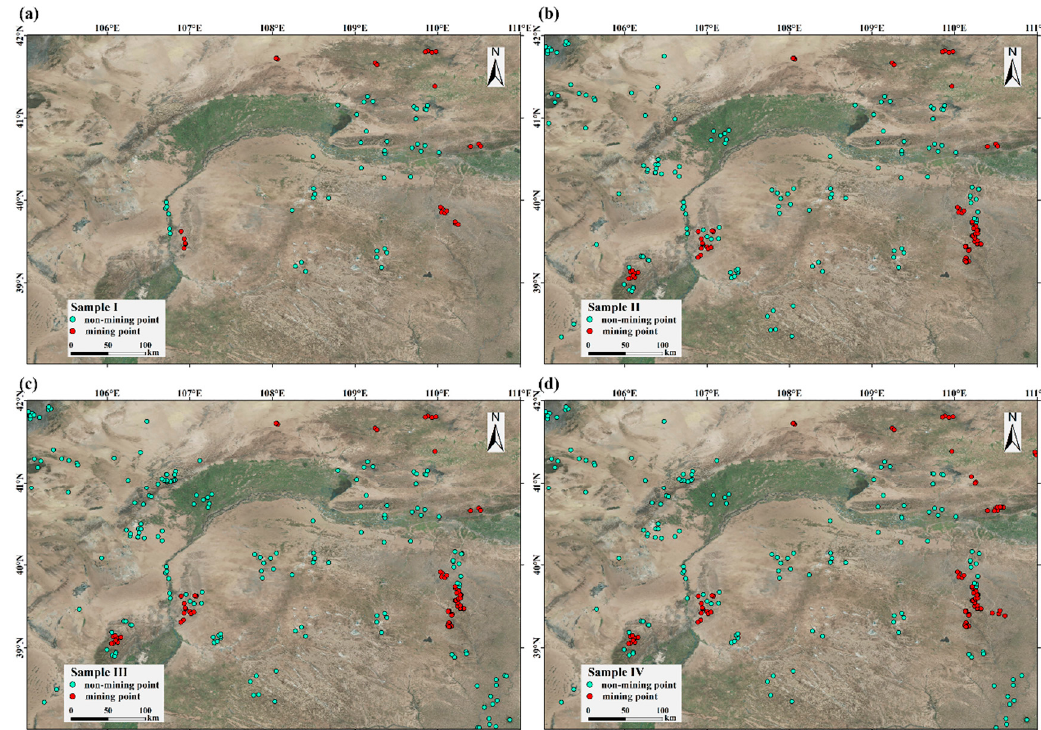
Figure 7. Distribution and number of sample points. ( a ) Sample I has only 72 sample points (mine points:non-mine points = 26:46), ( b ) Sample II has 213 sample points (mine points:non-mine points = 71:142, ( c ) Sample III has 253 sample points (mine points:non-mine points = 71:182, ( d ) Sample IV has 239 points (mine points:non-mine points = 85:154).